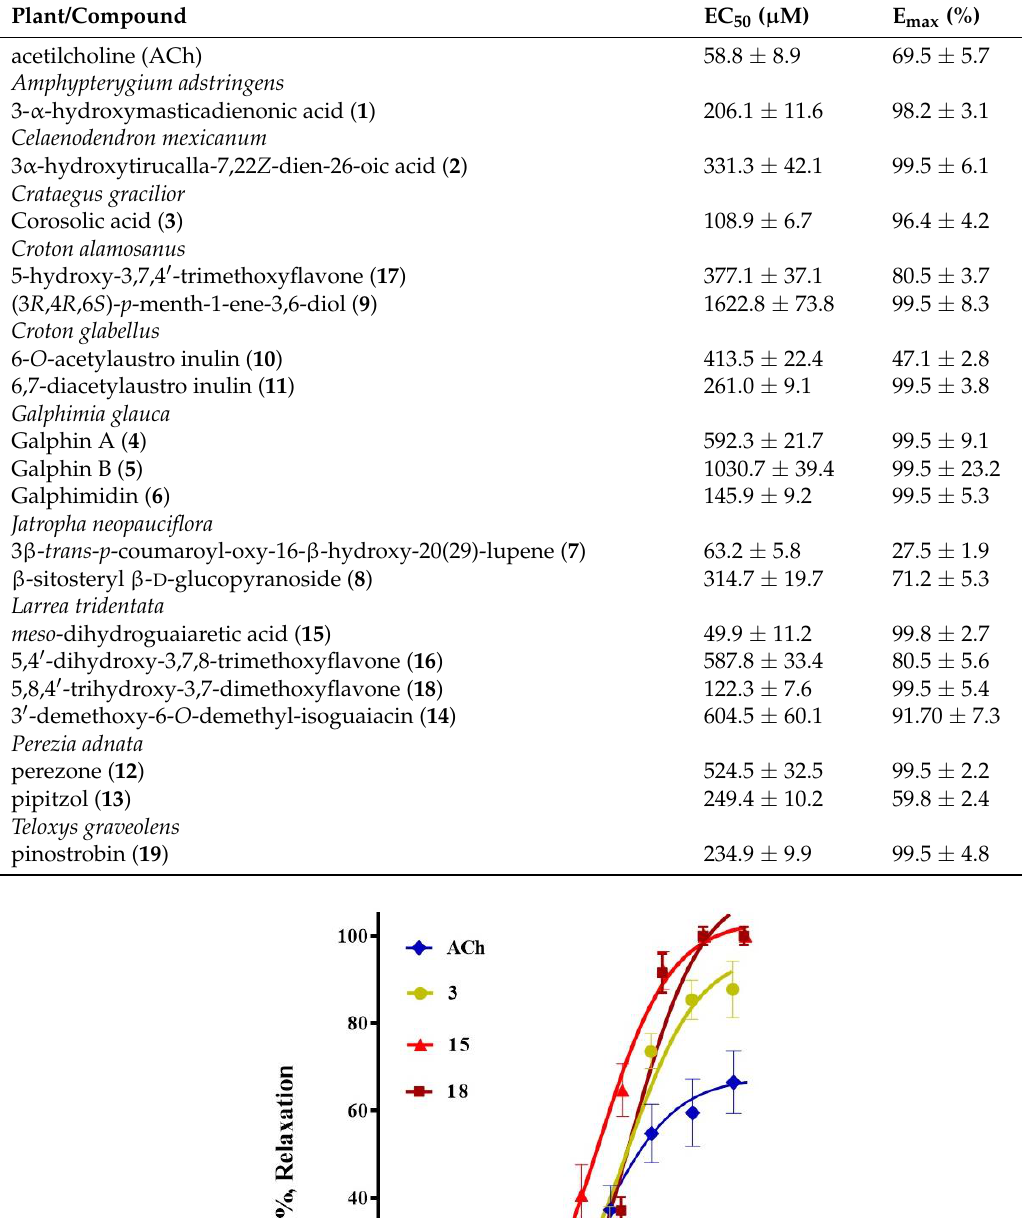
Table 1. Values of half maximal effective concentration (EC 50 ) and maximum effect (Emax) of positive control (Acetilcholine, ACh) and test compounds.